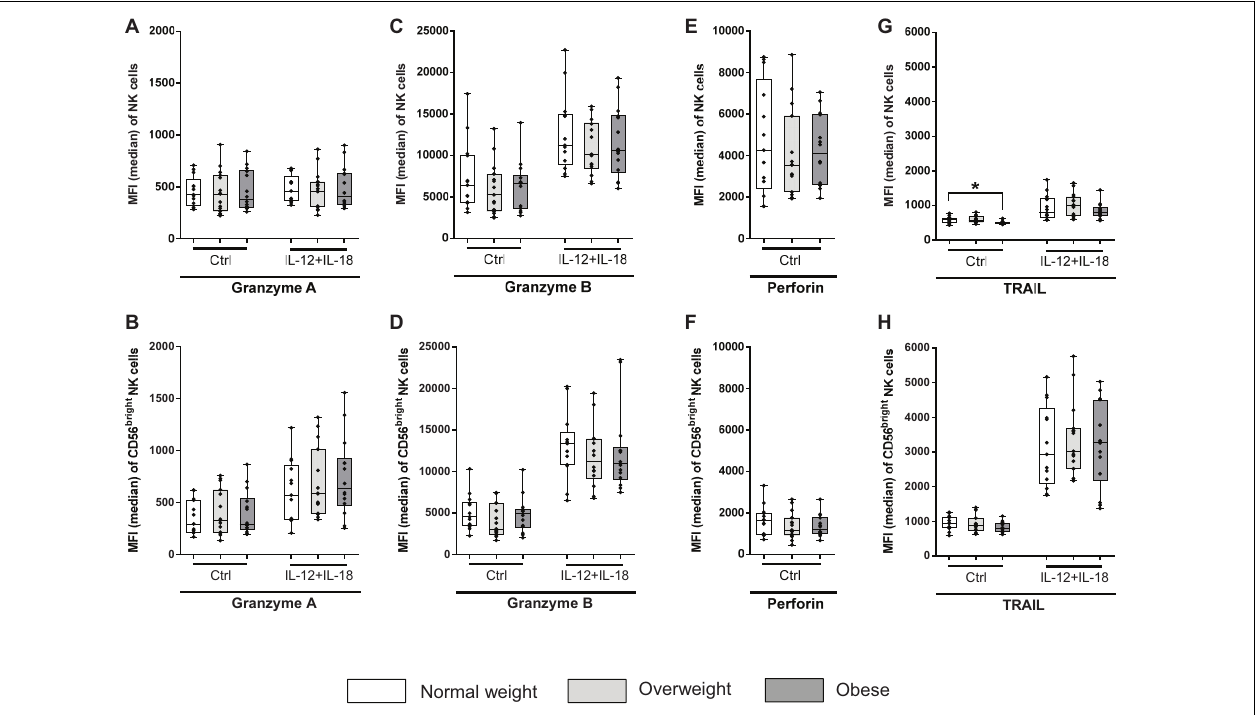
FIGURE 9 | Median fluorescence intensity (MFI) of intracellular granzyme A, granzyme B, perforin, and tumor necrosis factor–related apoptosis-inducing ligand (TRAIL) in NK cells and CD56 bright NK cell subset. PBMCs of blood donors with different body mass indexes [normal weight ( n = 13), overweight ( n = 15), and obese ( n = 14)] were either stimulated with 10 ng/ml interleukin (IL)-12 in combination with 50 ng/ml IL-18 overnight or remained untreated (perforin samples). (A,B) MFI of granzyme A + total NK cells (A) and CD56 bright NK cells (B) . (C,D) MFI of granzyme B + total NK cells (C) and CD56 bright NK cells (D) . (E,F) MFI of perforin + total NK cells (E) and CD56 bright NK cells (F) . (G,H) MFI of TRAIL + total NK cells (G) and CD56 bright NK cells (H) . Graphs are box and whisker plots with median ± minimum to maximum value; with additional dot plot representing individual donors. Overweight and obese groups were compared to normal weight control group. Statistical significance is indicated as: * P ≤ 0.05; Ctrl: unstimulated